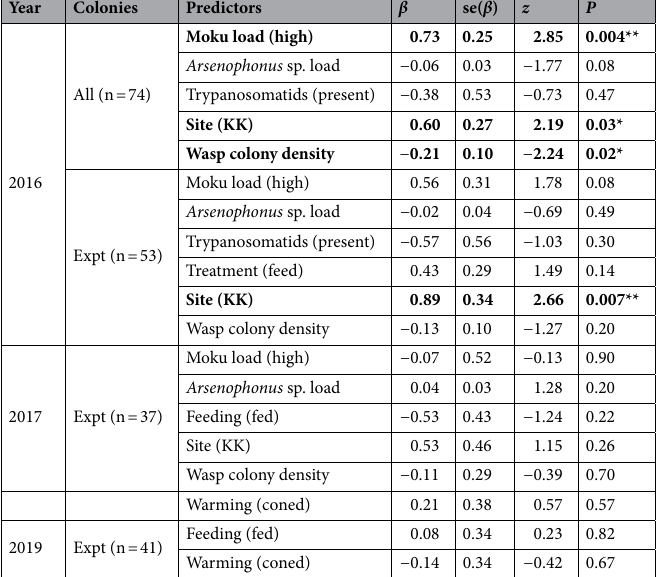
Table 2. Cox proportional hazard models of V. pensylvanica colony survival. *Indicates p < 0.05, **indicates p < 0.01; ***indicates p < 0.001. Note: bold lines indicate significant predictors. Positive coefficients ( β ) indicate a higher estimated hazard rate, i.e. reduced survival. Wasp colony density refers to the number of wasp colonies within 100 m of a focal colony. “Expt” colonies were those that were included in the feeding experiment in each